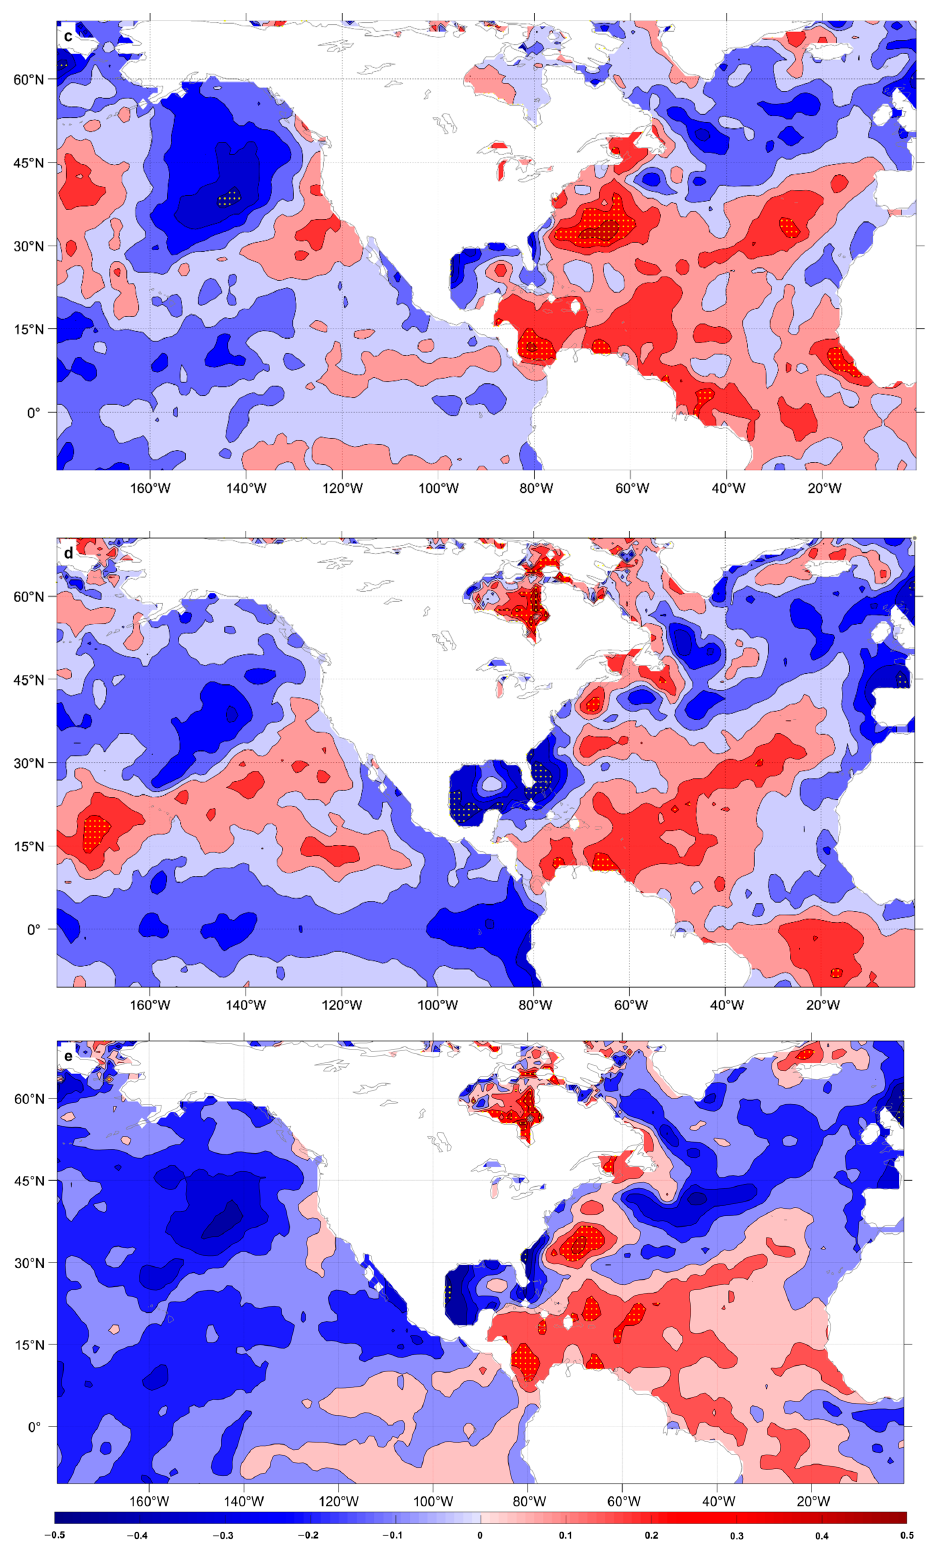
Figure 7. The correlation coefficient between the UBHI in extended winter and SST throughout the four seasons mean (( a ): spring; ( b ): summer; ( c ): autumn; ( d ): winter) and annual mean ( e ) (dotted area through the test of significance of 95%).